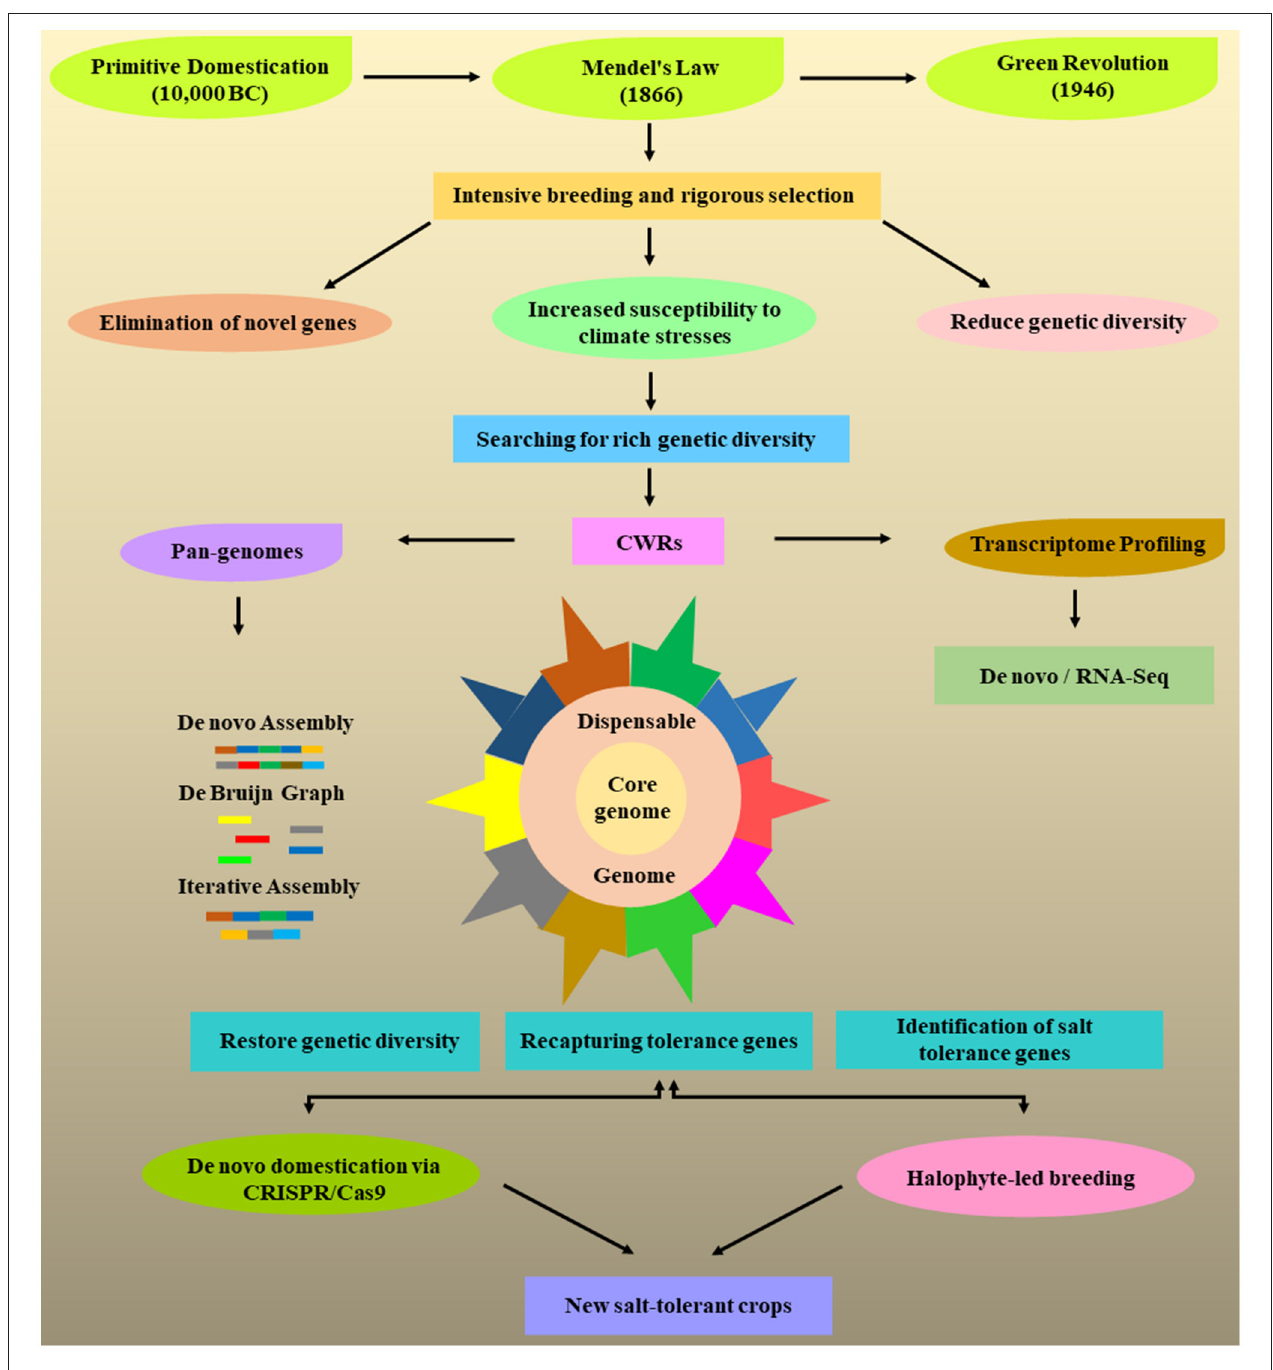
FIGURE 3 | Portrayed some major events in the history of plant breeding to increase the crop production. Like primitive domestication leads to the discovery of Mendel’s law to study the plant genetics and green revolution that select the specific agronomic traits to increase the crop yield. This intensive domestication led to the reduction in genetic diversity and crops become more susceptible to abiotic and biotic stresses due to the elimination of resistant genes. The crop wild relatives (CWRs) are vital to decipher the stress-responsive genes and can be exploited for transcriptional profiling of several unique salt tolerance genes through next-generation sequencing (NGS) technologies. The landraces cultivated and CWRs are used to construct the high quality pangenomes for crop improvement. The pangenomes consist of core and dispensable genomes representing all the genes present within a species. It helps to increase the genetic diversity of a species and recapture the unique genes that have been lost during domestication. The detection of stress-tolerance genes can be applied to produce salt-tolerance crops through de novo domestication using CRISPR/Cas9 system. On the other hand, halophytes provide an alternate strategy to cope with the salt stress and can be exploited in breeding programs to develop new crops with increased salt tolerance or improve the current cultivated